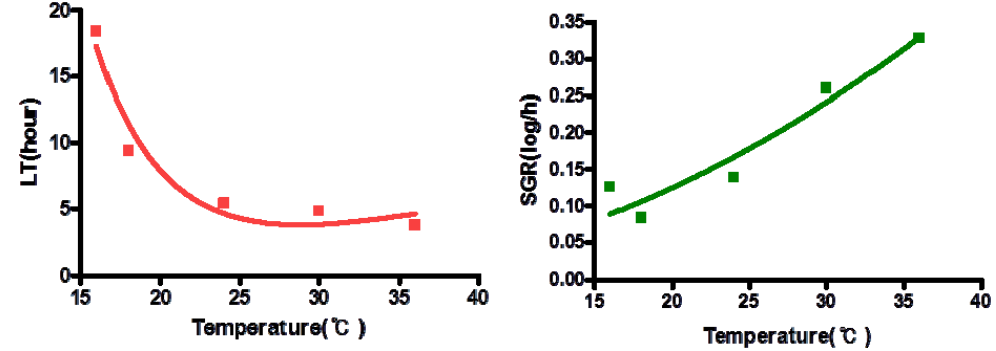
Figure 3. Effect of temperature on the values of lag time (LT) and specific growth rate (SGR) of natural V. vulnificus in oysters. Data (n = 4) for LT and SGR were fitted using Equations (2) and (3), respectively.